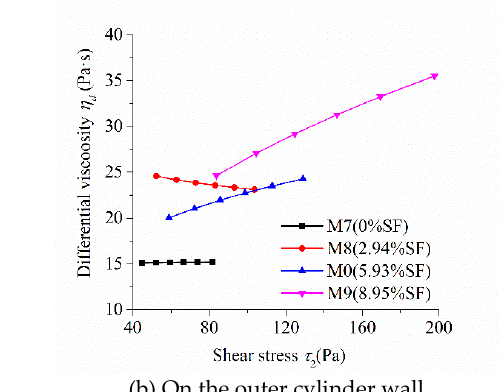
Figure 11. Relationship between the differential viscosity and shear stress of mortars with different SF contents. Figure 12 reveals the relationship between the differential viscosity of mortar with different dosages of SP and shear stress. The differential viscosity of mortars M10, M0,